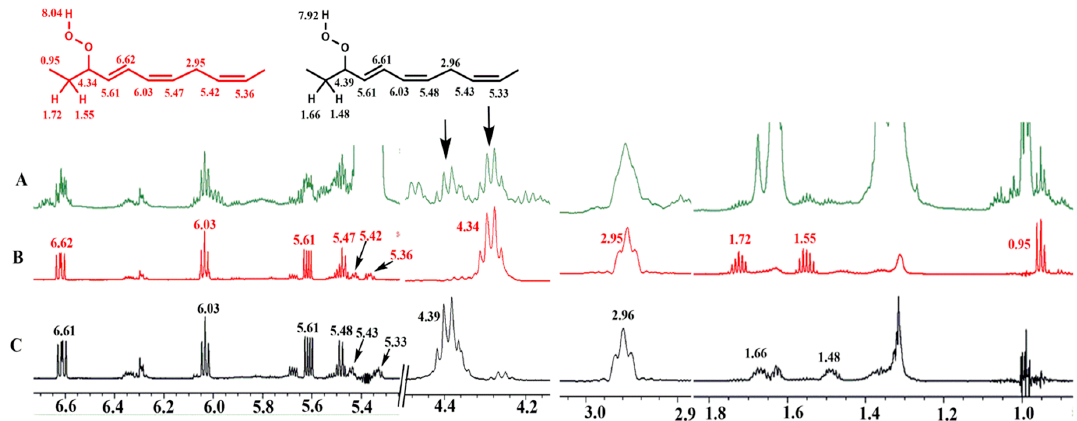
Figure 5. ( A ) 800 MHz 1D 1 H-NMR spectrum of 20 mg methyl linolenate, subjected to heating at 40 ◦ C for 48 h, in CDCl 3 (acquisition time = 1.02 s, relaxation delay = 5 s, number of scans = 128, experimental time = 10 min), T = 298 K. ( B ) and ( C ) selective 1D TOCSY spectra of the same solution using a mixing time of τ m = 300 ms. The arrows denote the selected resonances that were excited at δ 4.34 ( B ) of the 9- cis , 12- cis , 14- trans -16-OOH hydroperoxide and δ 4.39 ( C ) of the 10- trans , 12- cis , 15- cis -9-OOH hydroperoxide. Number of scans = 256, experimental time = 20 min.